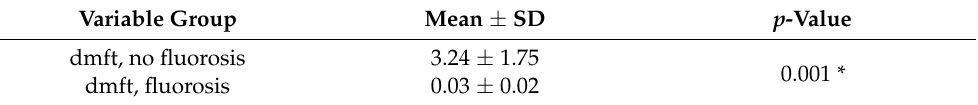
Table 2. The dmft status of study